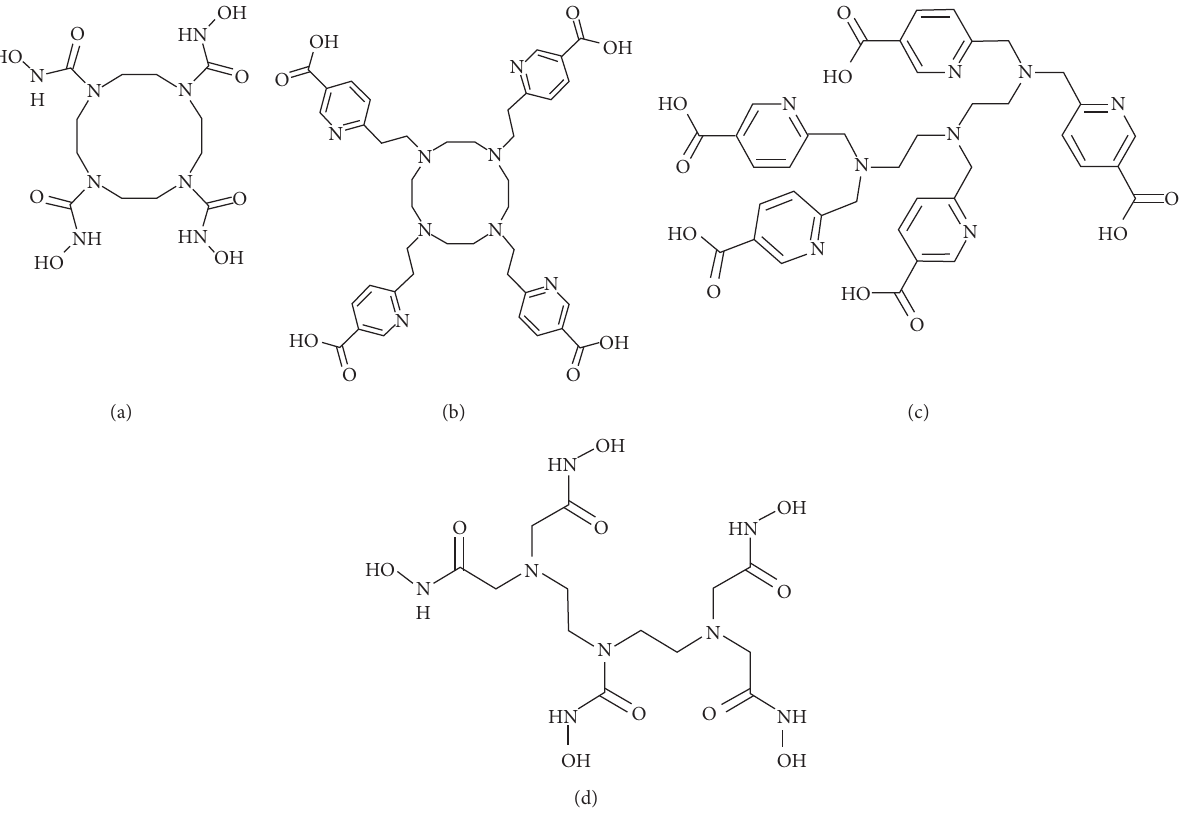
Figure 2: Novel chelating agents: (a) TTCC, (b) TCTN, (c) CMAT, and (d) BOEN studied for iron sulfide scale